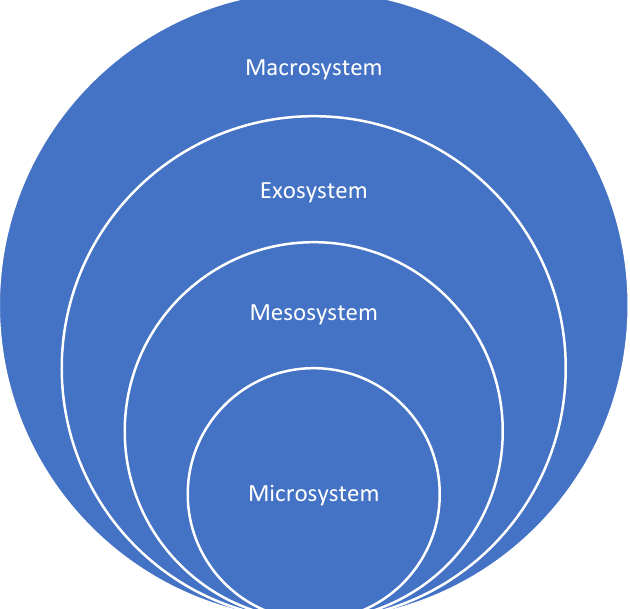
Figure 1. The features of the original ecological systems theory (EST) model formulated by Bronfenbrenner (1979).